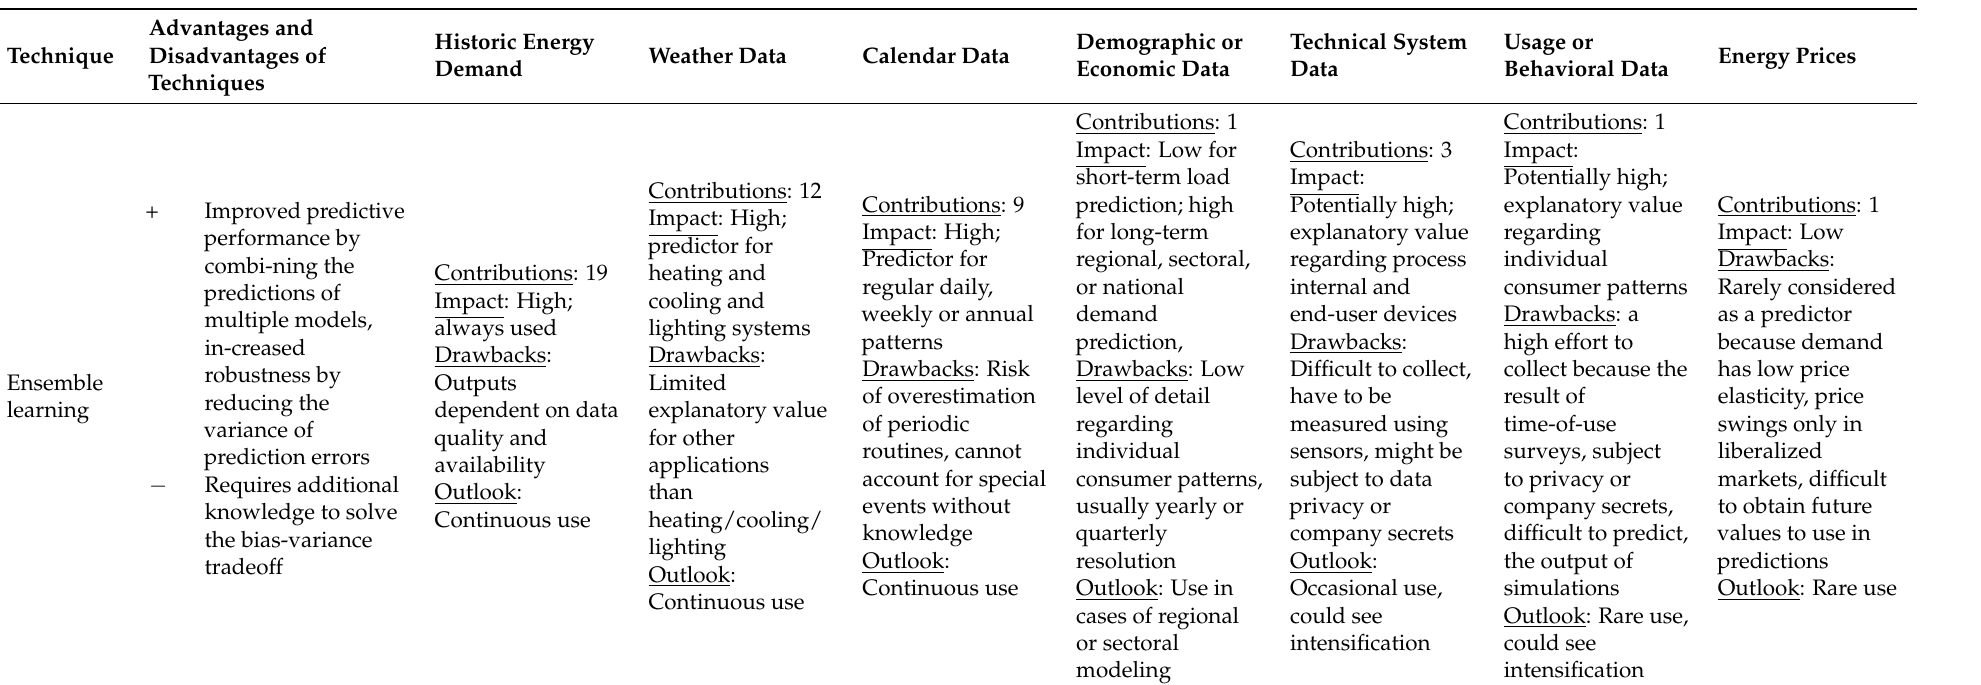
Table 5. Techniques and input data used